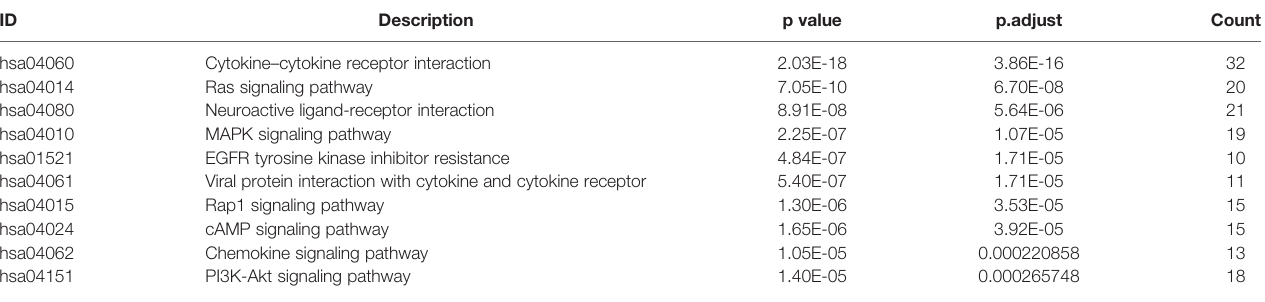
TABLE 2 | KEGG pathway enrichment of IRGs for PCa patients. ID